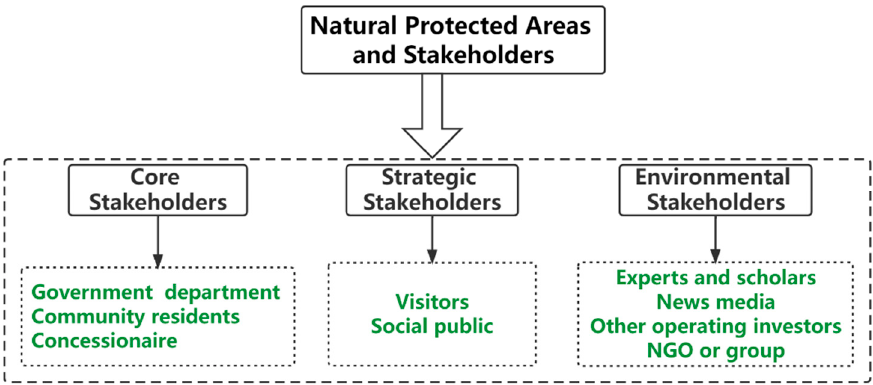
Figure 6. Stakeholder composition characteristics. The terms and scheme used in the present figure were according to Carroll and Buchholtz (1993) with modification.